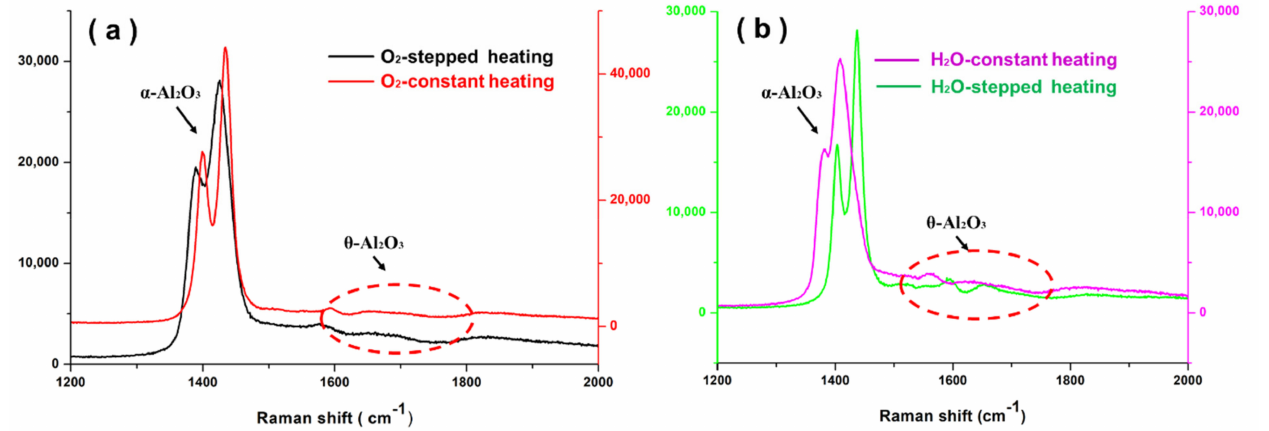
Figure 4. The Raman spectra of the oxide scale formed on NiCrAlHf bond coat alloy in different atmospheres and using different heating methods after 24 h of oxidation at 1100 ◦ C: ( a ) in air; ( b ) in water